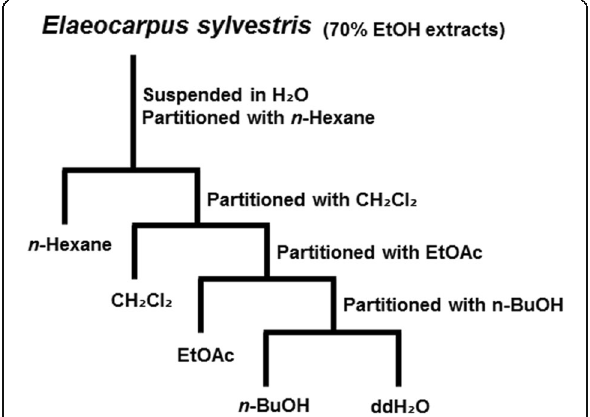
Fig. 1 Fractionation scheme for